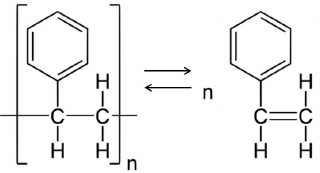
Figure 5. Fourier-transform infrared (FT-IR) spectra of samples: neat polystyrene (PS), PS-CNWs-1%, PS-CNWs-3% and PS-CNWs-5% samples.